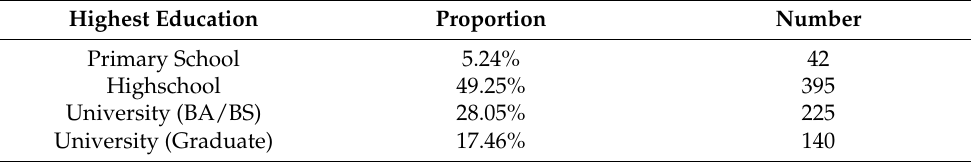
Table 3. Education